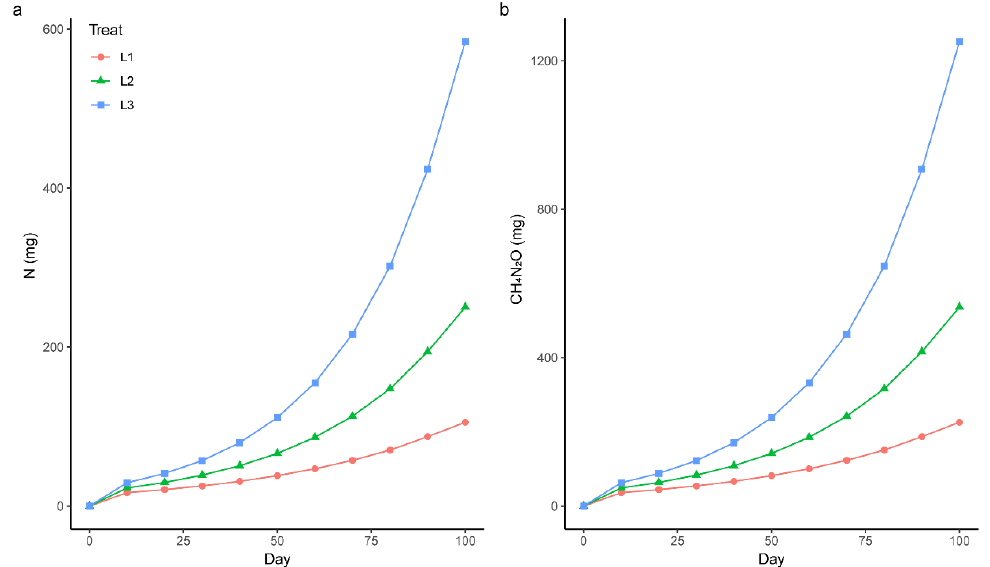
Figure 1. The schedule of N fertilization during the 100 days study; ( a ) is the cumulative usage of N, and ( b ) is the cumulative usage of CH 4 N 2 O (urea). Different colors and symbols indicate the different